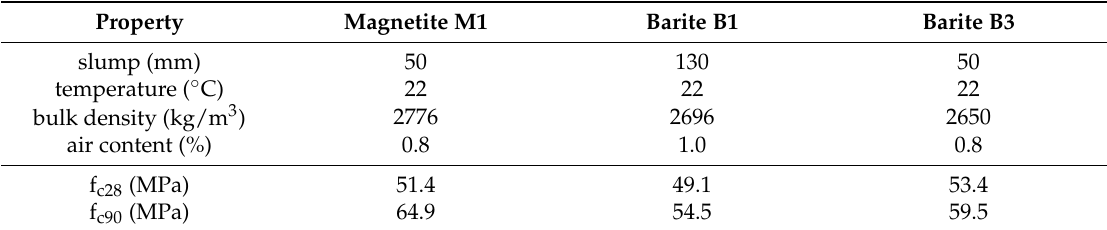
Table 2. Properties of concrete mixes and the compressive strength after 28 and 90 days of curing.